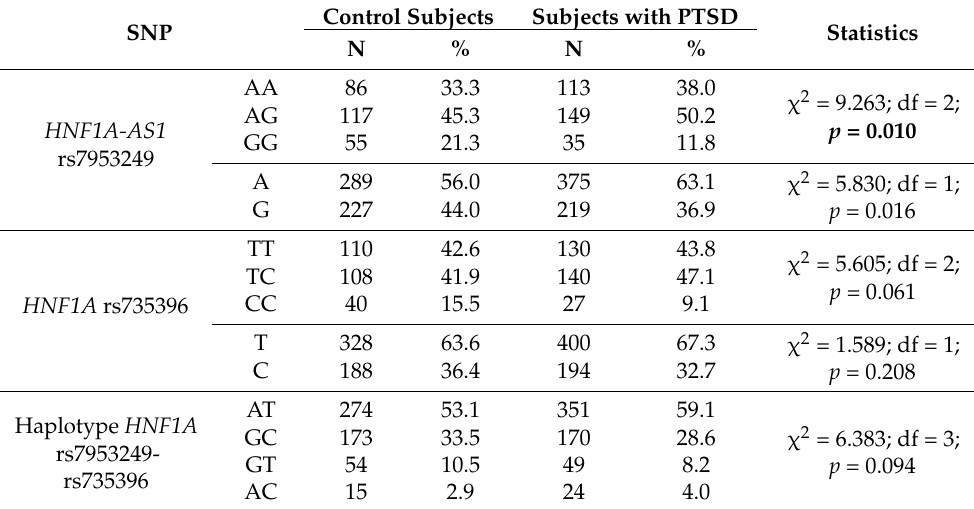
Table 1. Distribution of genotypes, alleles and haplotypes of HNF1A-AS1 rs7953249 and HNF1A rs735396 polymorphisms in control subjects and patients with PTSD.